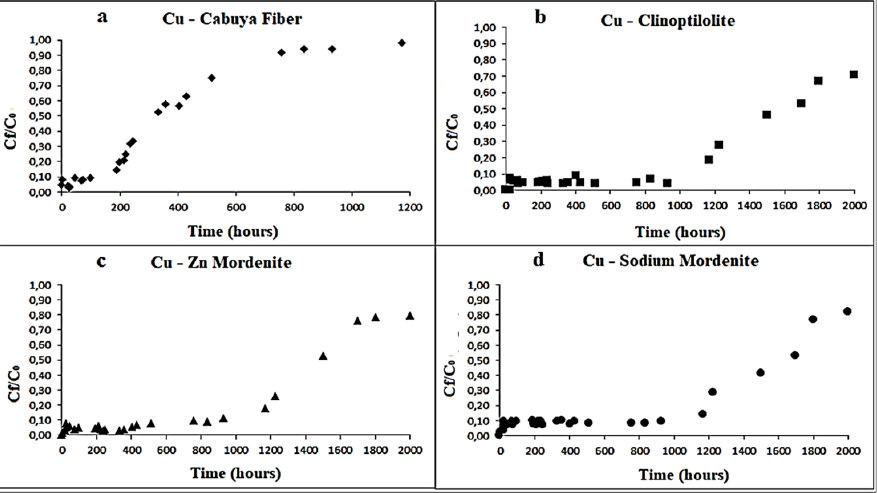
Figure 4. Variation of Cu concentration over time, in the column tests, for the following reactive materials: ( a ) cabuya fiber; ( b ) clinoptilolite zeolite; ( c ) mordenite zeolite; ( d ) sodium mordenite ze-